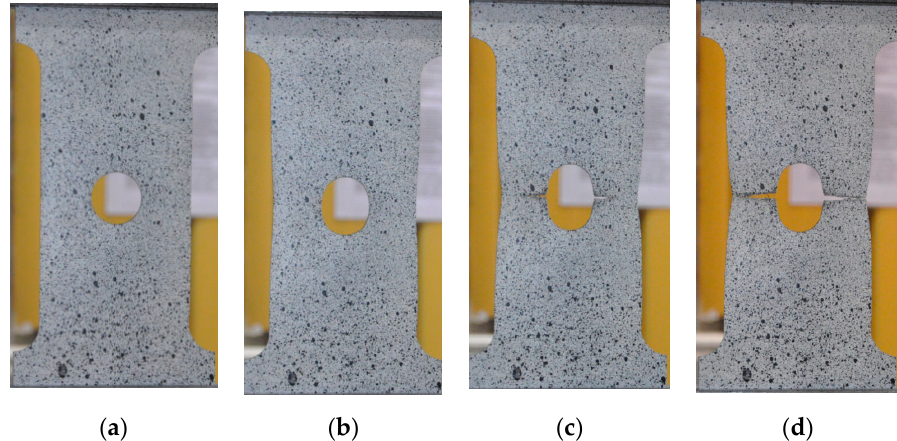
Figure 11. Tensile behavior of plate with circular hole made of S235JR + N: ( a ) Point 4; ( b ) Point 7; ( c ) Point 9; and ( d ) Point 10. The points are given in Figure 10.